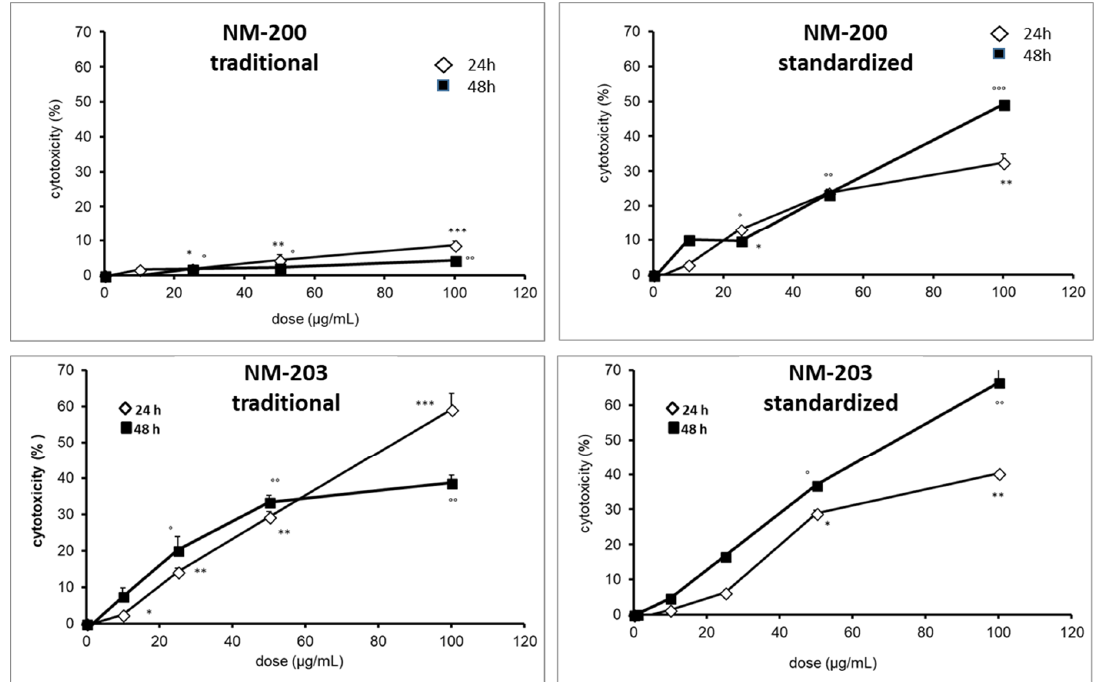
Figure 8. Effect of the dispersion protocols on the cytotoxicity of NM-200 and NM-203 towards RAW 264.7 cells measured as LDH leakage. Each measurement was performed in duplicate, and data are presented as means ± SEMs (n = 3 readings): *** p < 0.001 vs. ctrl; ** p < 0.002 vs. ctrl; * p < 0.05 vs. ctrl; °° p < 0.001 vs. ctrl; ° p < 0.02 vs. ctrl.